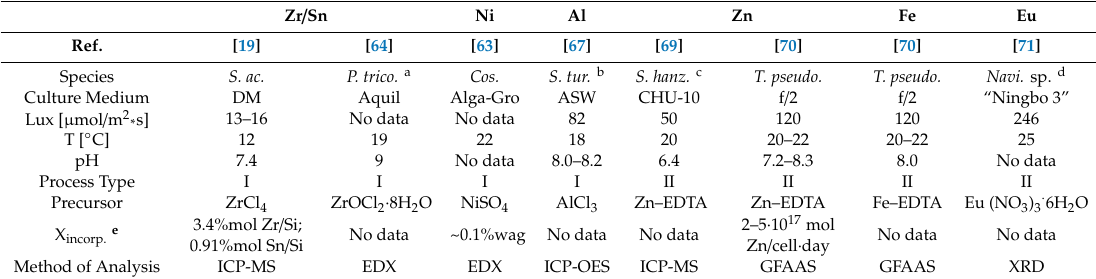
Table 5. Summary of results of doping diatoms with metal ions. Zr /